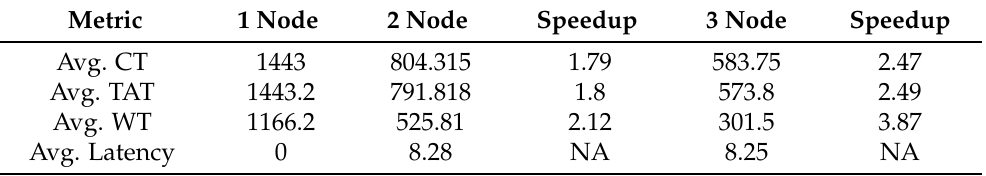
Table 9. Performance Comparison of DeepStack Cluster with Single Node